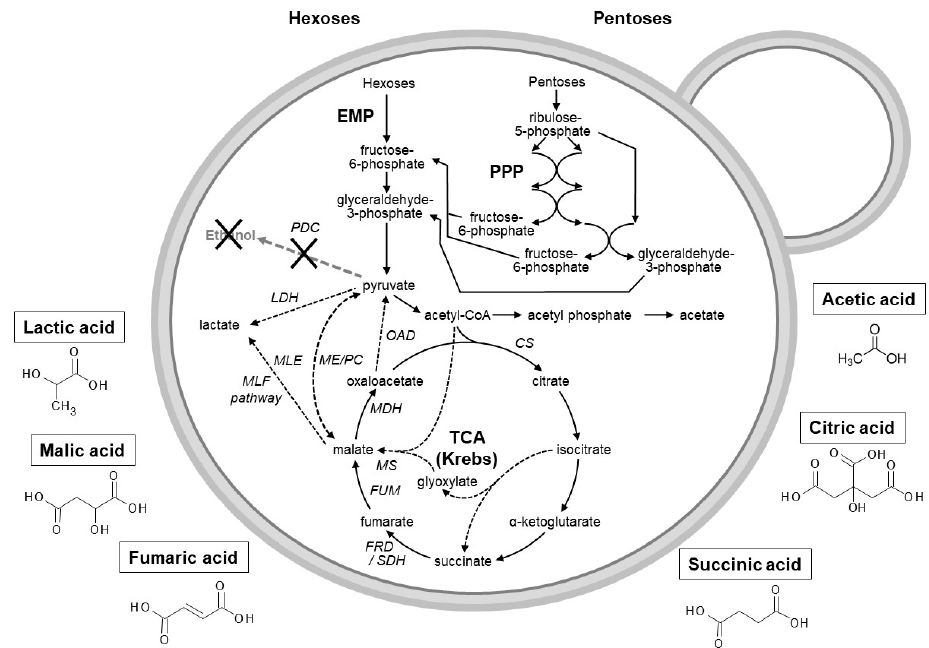
Figure 2. Metabolic pathways for the conversion of hexoses and pentoses to organic acids in S. cerevisiae . A simplified illustration of the TCA cycle showing the interconnectedness of various metabolic pathways in eukaryotic mitochondria. Steps in the Embden–Meyerhof–Parnas (EMP) pathway, pentose phosphate pathway (PPP) and TCA cycle are indicated by solid lines, whereas alternative bioconversions are indicated by dashed lines, i.e., recombinant malolactic fermentation (MLF) pathway and glyoxylic acid cycle (GAC). Grey dashed arrows indicate a pathway often deleted or interrupted (such as PDC and alcohol dehydrogenase to produce lactic acid) or an alternative pathway utilized (such as ME for the conversion of malate to pyruvate). The relevant enzymes are indicated as (CS (citrate synthase), FRD (fumarate reductase), FUM (fumarase), IDH (isocitrate dehydrogenase), LDH (lactate dehydrogenase), MDH (malate dehydrogenase), ME (malic enzyme), MLE (malolactic enzyme), MS (malate synthase), OAD (oxaloacetate decarboxylase), OGDH ( α - ketoglutarate dehydrogenase), (KGDH) α -ketoglutarate dehydrogenase, PC (pyruvate carboxylase), PDC (pyruvate decarboxylase) and SDH (succinate